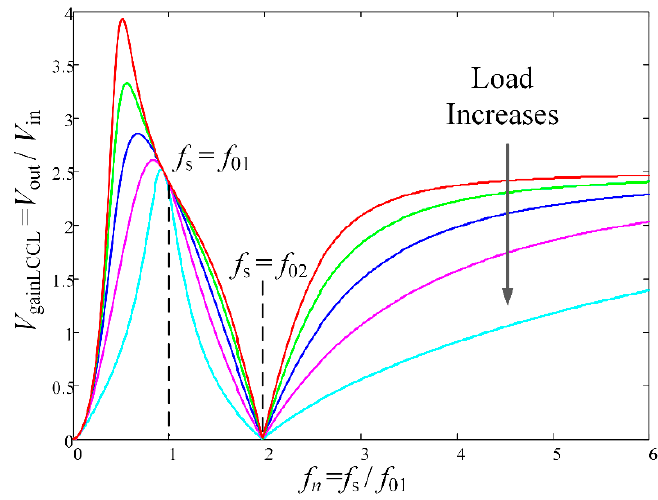
Figure 6. DC voltage gain curves of the LCCL resonant converter.